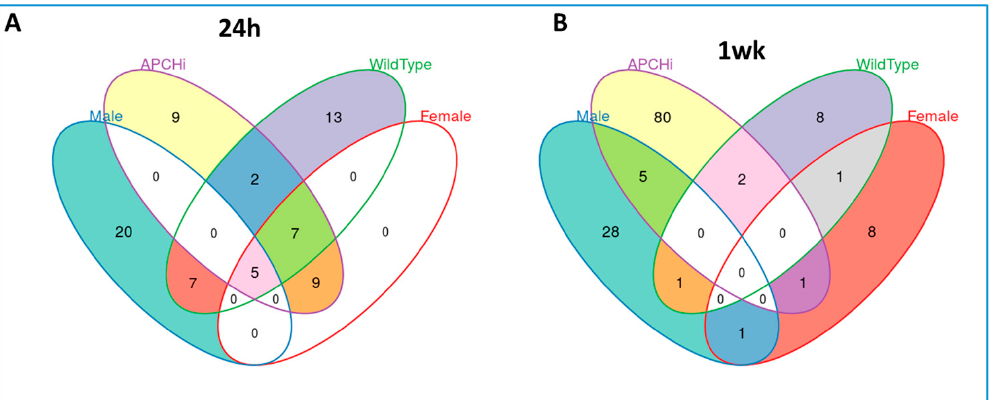
Figure 4. Venn diagram detailing the unique biomarkers for radiation response speci fi c to each group comparing radiation versus sham dependent and independent of sex and genotype, analyzed by targeted mass spectrometry. (Panel A ). 24 h’ post-irradiation, (Panel B ). 1 week after radiation.